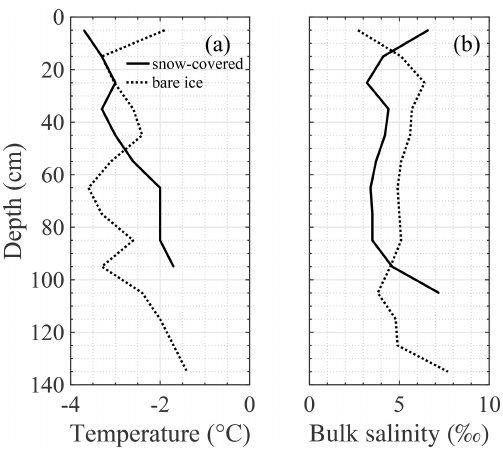
Figure 8. Profiles of (a) T and (b) S measured on ice cores nearby optical measurement holes at both